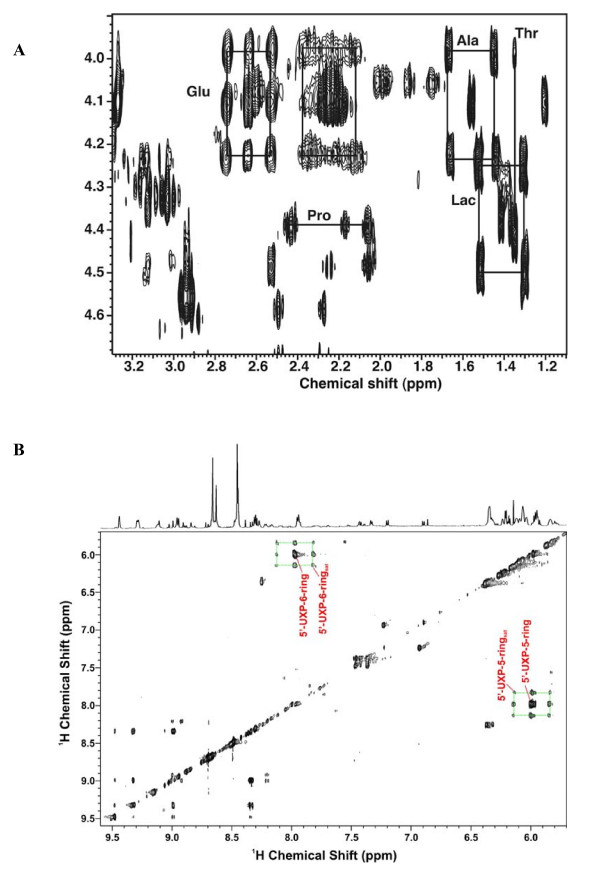
TOCSY Spectra of Rh30 cell extract. Expansion of the spectrum shown in Figure 8. A. Glu/Ala/Lac region expansion from A. The boxes show the 13C satellite peaks for Ala, Lac and Glu and the absence of labeling in Pro and Thr. Ala and lactate show only fully unlabeled and fully labeled cross peak patterns, whereas the Glu cross peak patterns exhibit both singly and doubly labeled isotopomer species (cf. [35]. B. The partial TOCSY spectral region displays the cross-peak patterns of singly and doubly labeled species for the 5- and 6-ring protons of 5'UXP.